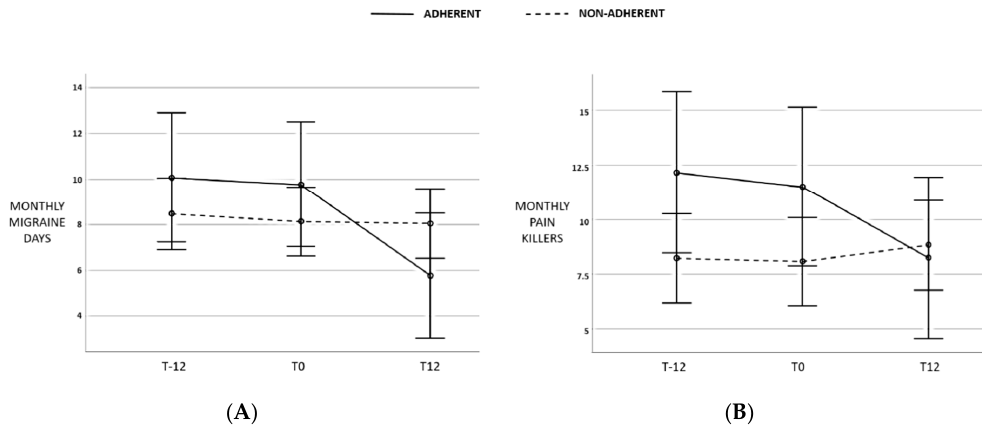
Figure 2. Changes ( A ) in monthly migraine days (MMDs) and ( B ) painkiller intake in ADHERENTS compared with NON-ADHERENTS in the month preceding T12. Bars indicate 95% confidence intervals. Table 4. Changes in food group weekly intake in RESPONDERS compared with